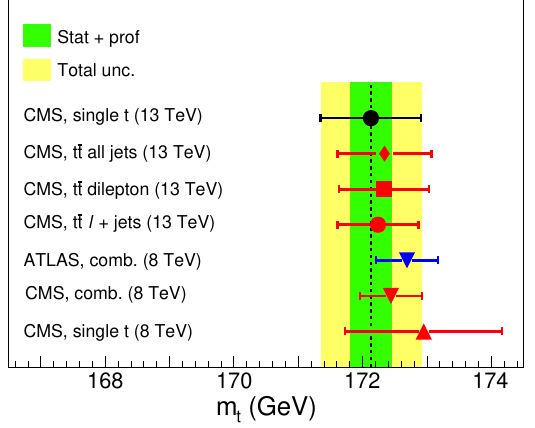
values from this analysis (black circle), from previous Figure 9 . A comparison of measured m t √ CMS results in tt events at s = 13 TeV for fully hadronic [10], dileptonic [14], and semileptonic [9] √ final states, and from ATLAS [7] and CMS [8, 22] analyses at s = 8 TeV. The horizontal bars on the points show the combined statistical and systematic uncertainties in each measurement. The vertical dashed black line indicates the central value obtained from this measurement in the l ± final state. The green band represents the combined statistical and profiled systematic uncertainties in the present result, whereas the yellow band shows the total uncertainty.